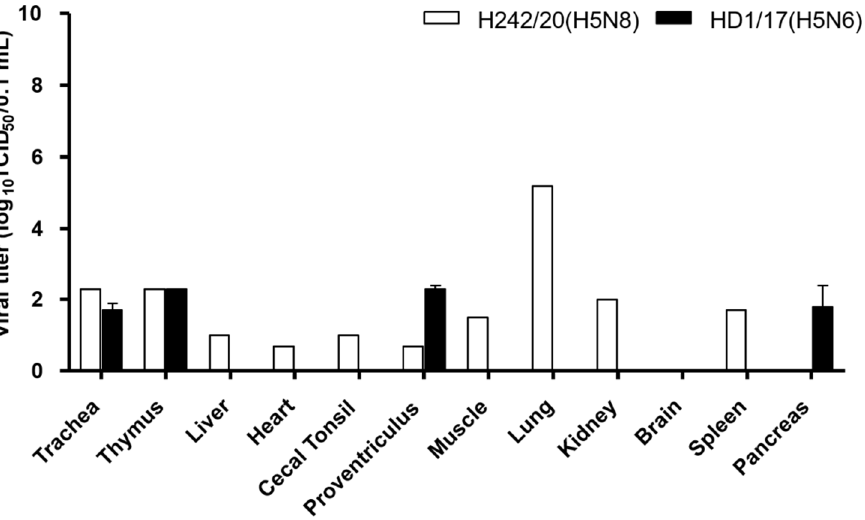
Figure 4. Virus titer of H242/20(H5N8) virus and HD1/17(H5N6) virus in various organs from ducks, which were inoculated intranasally with a viral dose of 10 6 EID 50 . H242/20(H5N8) virus and HD1/17(H5N6) virus infected organ tissues were collected at 3 dpi. The virus titers of the organ tissues (10% homogenates) were measured in chicken embryo fibroblast cell (DF-1). Data shown indicate the average of calculable positive organ titer.